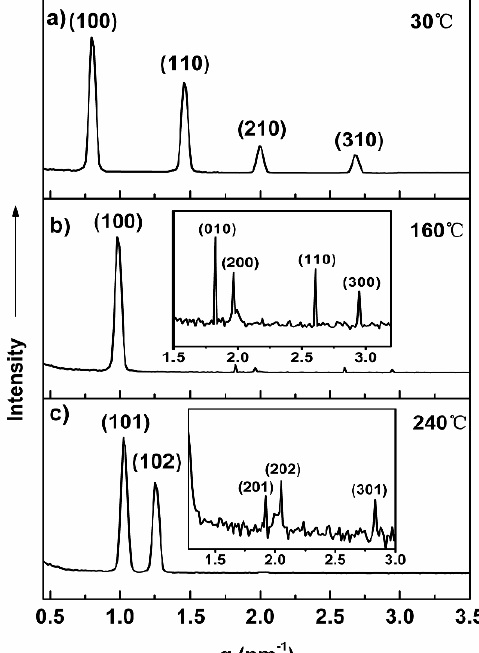
Figure 3. Small-angle and wide-angle X-ray diffraction patterns of 1b plotted against q (=4 π sin2 θ / λ ). ( a ) Rectangular column at 30 °C; ( b ) Oblique column at 160 °C; and ( c ) Hexagonal close-packed structure measured at 240